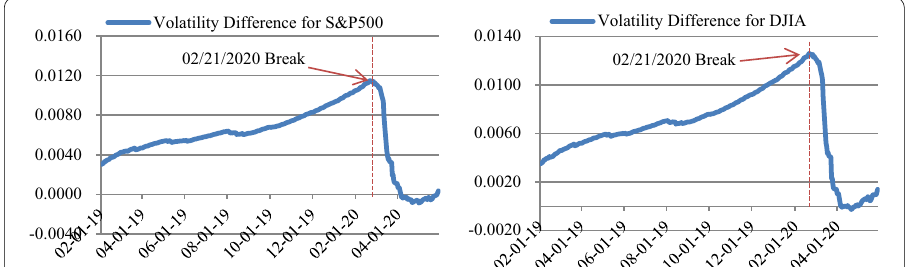
Fig 3. Difference of Volatility between Subsamples: 02/01/2019–05/31/2020. Notes : Figure 3 plots the difference of the realized volatility between two subsamples partitioned at a given